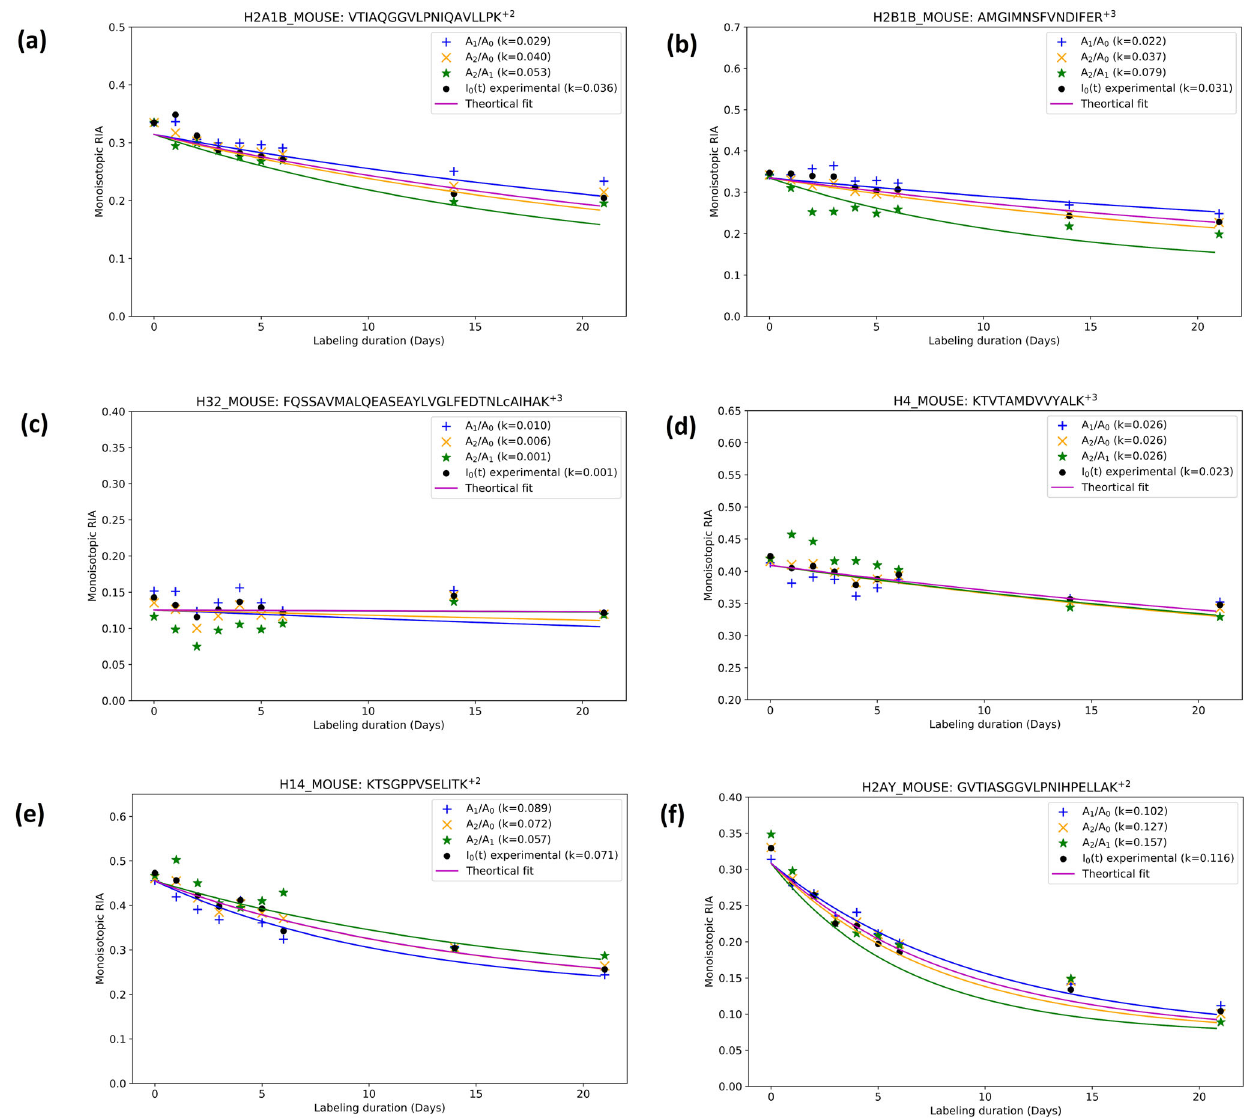
Fig. 6 The turnover rates of histones are accurately computed by the approach using two mass isotopomers. Slow turnover rates of Histones are re fl ected in the time series of label incorporation obtained using complete (experimental) isotope pro fi les and reconstructed isotope pro fi les (using a pair of mass isotopomers). Shown are the labeling time series data of a peptide of histones: ( a ) H2A1B (histone 2A type 1-B), ( b ) H2B1B (histone 2B type